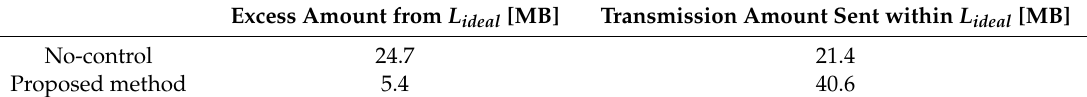
Figure 5. Learning result in basic evaluation: ( a ) total reward; ( b ) average q ‐ value. Table 4. Excess volume and transmission volume for basic evaluation.